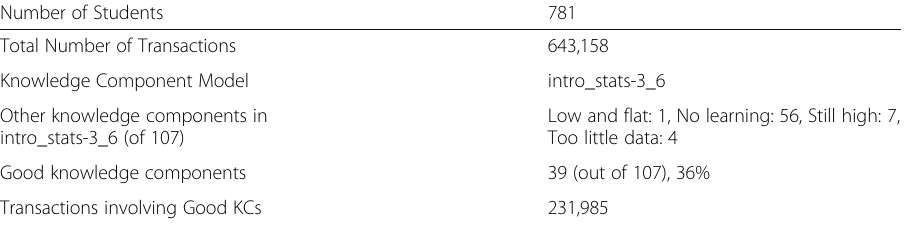
Table 6 Statistics course data summary for the 2015 course Number of